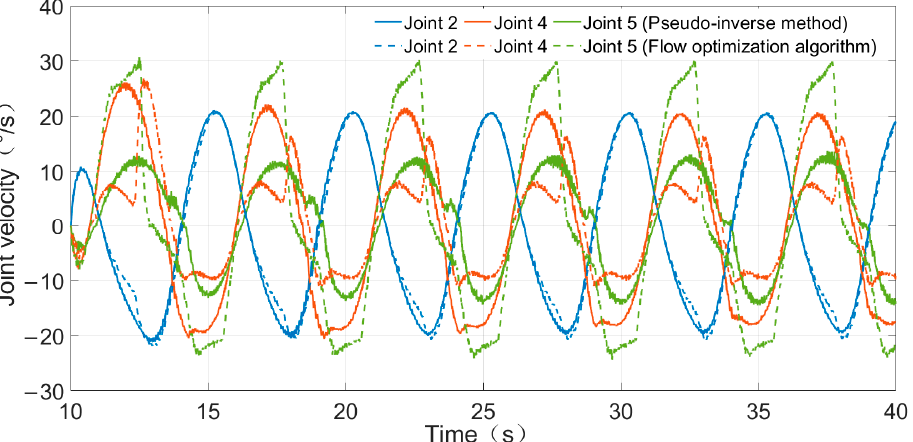
Figure 9. The actual joint velocity according to the pseudo-inverse method and the flow optimiza- tion algorithm in the experiments.